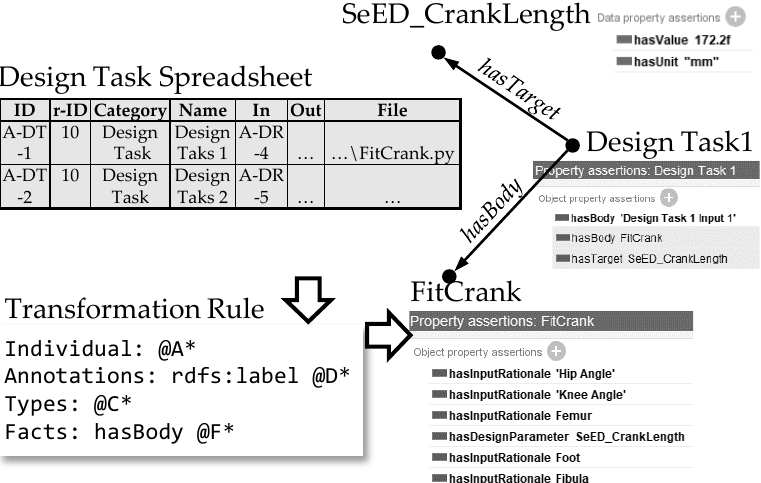
Figure 11. Illustration of an example of the instantiation of a Design Task from data tables.